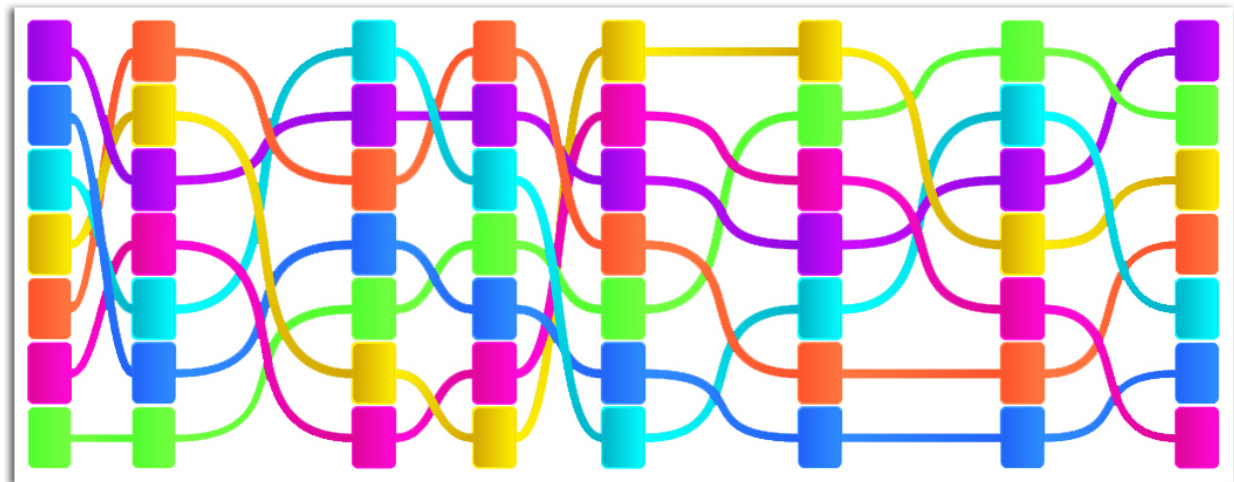
Figure 6. Game situations are typically more complex due to interdependencies within and between the teams. We automatically split identified complex and hardly interpretable moves into several understandable parts and visualize these. In this case, we represent a descriptive part of a move as a feature. Features are visualized as rectangles and ranked such that the topmost ranked feature is represented by the topmost rectangle.